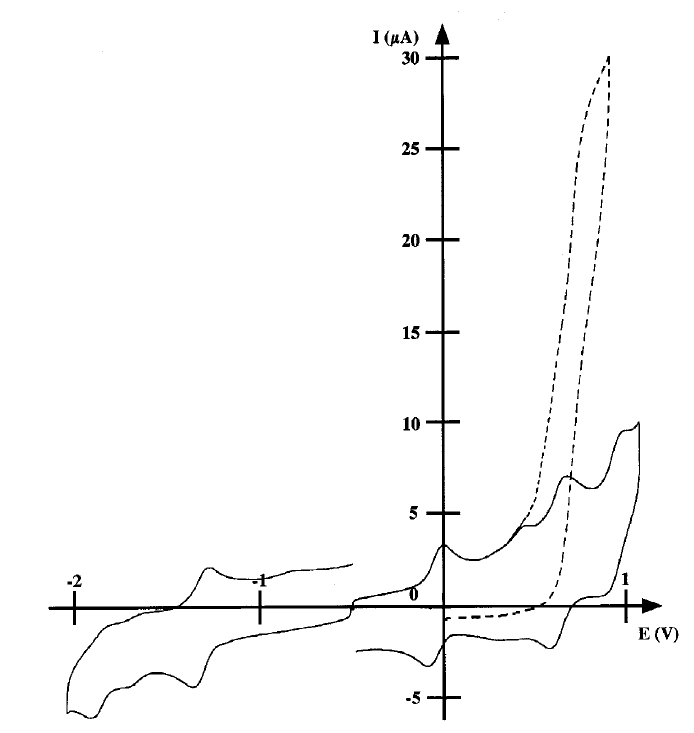
Figure 1 : Cyclic voltammograms for 1 (full line) and 2 (dashed line) 0.15mM in CH 3 CN + 0.1 M TBAP recorded at a carbon electrode. Scan rate: 100 mVs -1